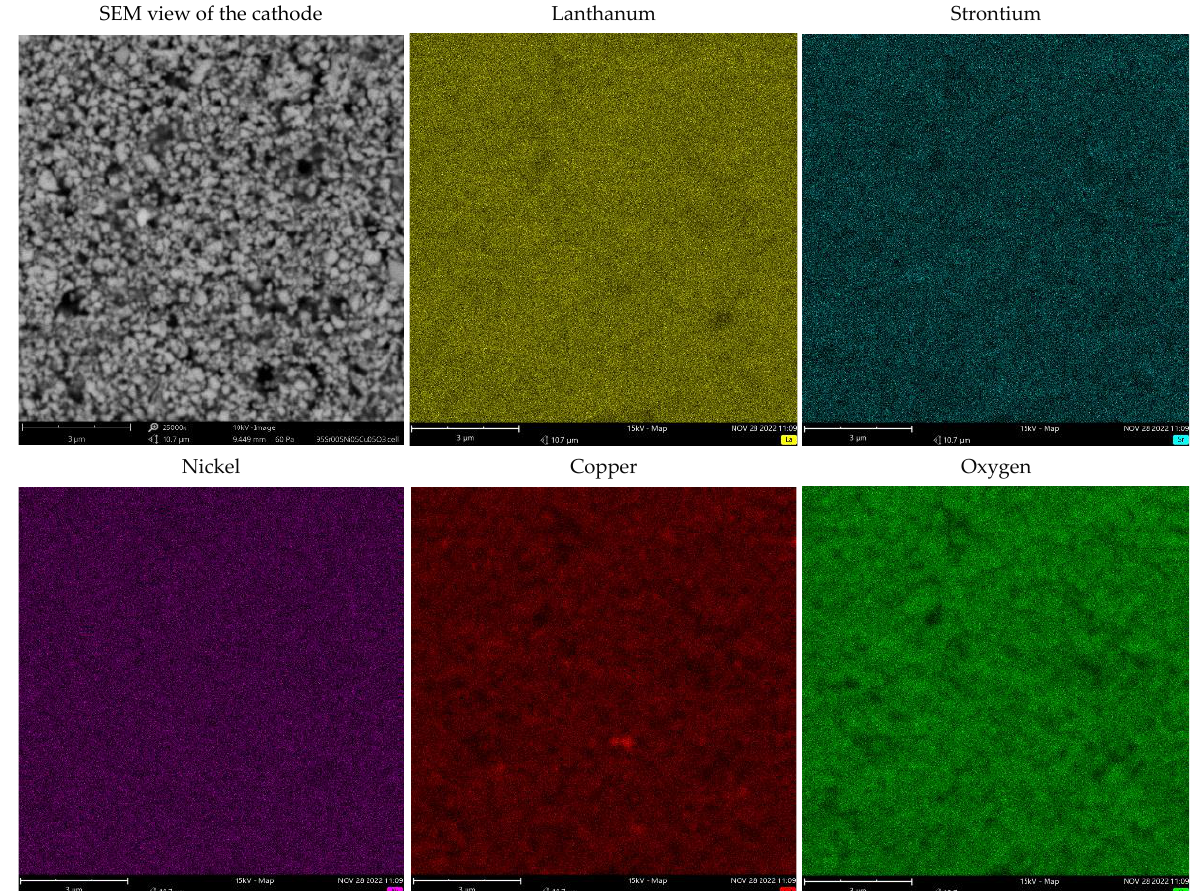
Figure 13. EDS map of element distribution in the La 0.95 Sr 0.05 Ni 0.5 Cu 0.5 O 3−δ cathode after cell tests.